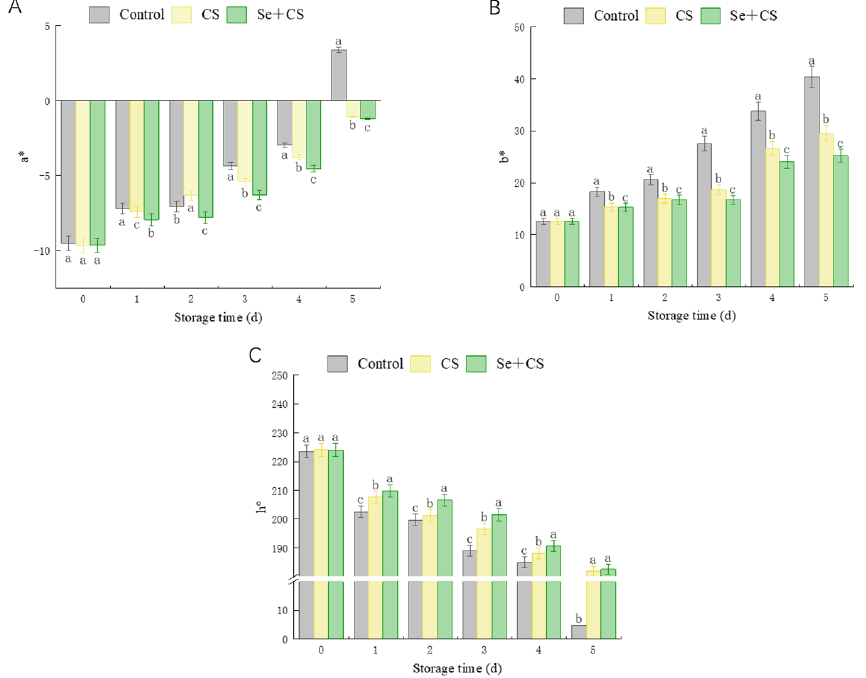
Figure 1. Hunter’s color value in fresh − cut broccoli treated with Se+CS during storage. ( A ). a*. ( B ). b*. ( C ). h°. Different letters represent significant differences in the same group during storage ( p < 0.05) by Duncan’s multiple range test.